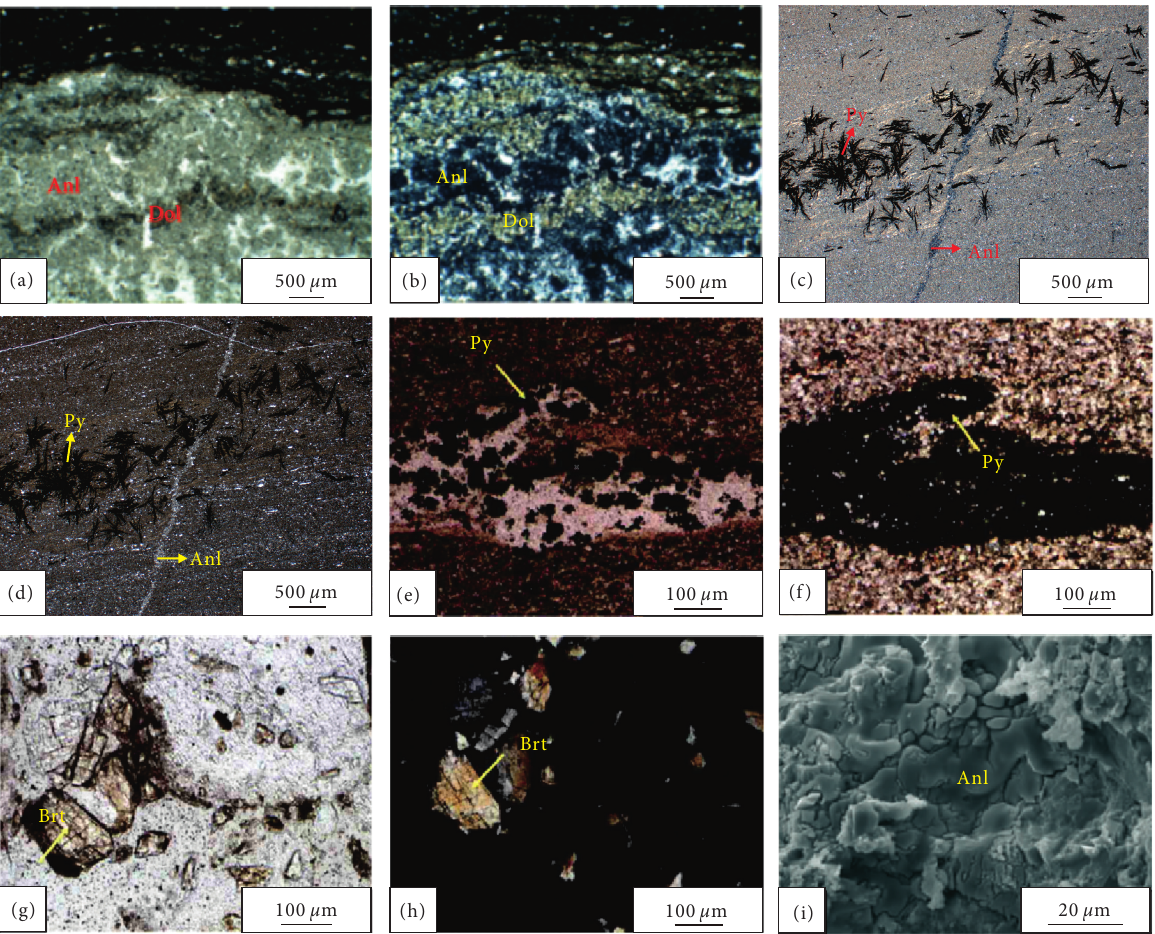
Figure 11: Analcime formed by hydrothermal deposition mineralization. (a, b) Analcime enriched in laminae and interbedded with dolomite [20]. (c, d) Interbedded fractures are filled with hydrothermal analcime. (e, f) Pyrite and analcime distributed in dolomite